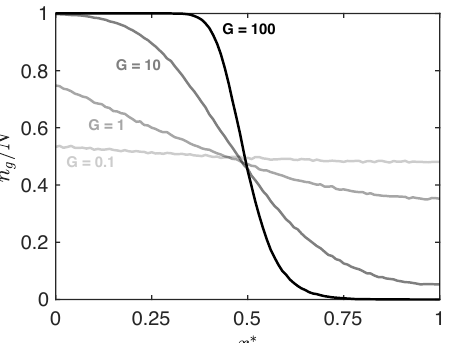
Figure 7. Comparison of predicted surface coverage profiles as a function of parameter G . Each curve is extracted from Monte Carlo simulations at the time when the average surface coverage reaches Φ = 0.50. In all cases shown, δ ∗ = 0.01 and L ∗ = 1, with the value of P g varied to obtain the different G factors (Equation (4)). Each curve represents the average result over 500